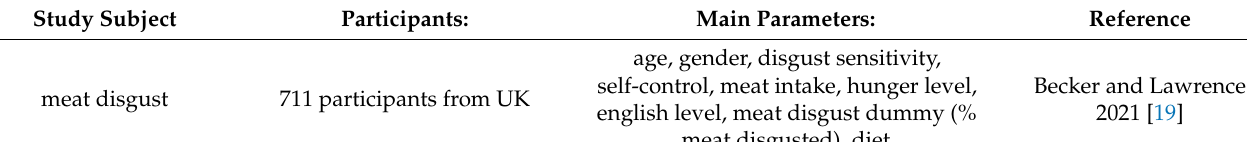
Table 2. Research on consumer attitudes towards meat analogues, meat and plant-based